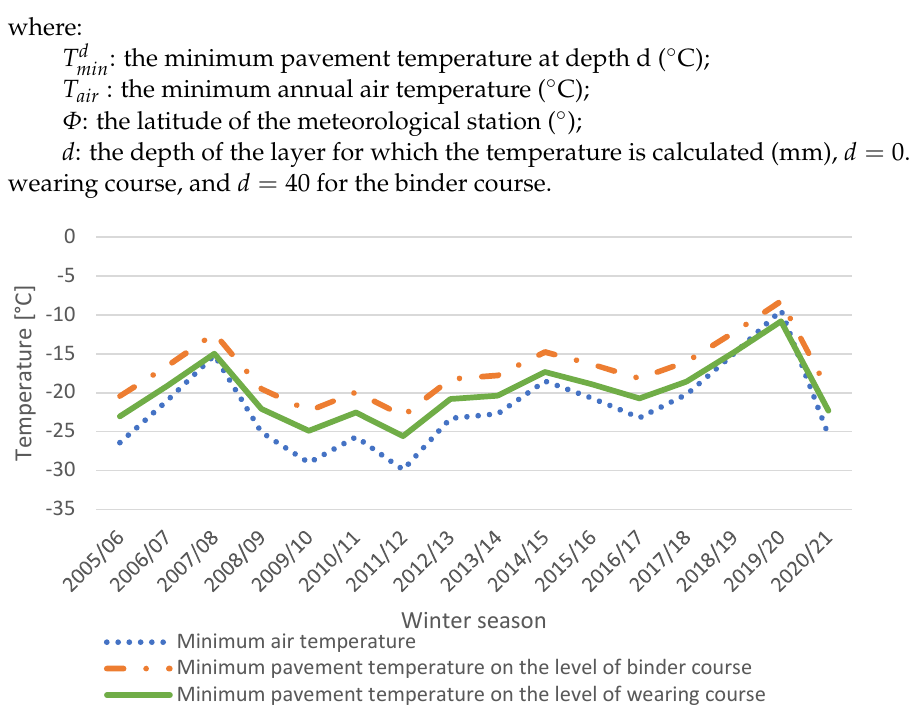
Figure 1. Minimum air and pavement temperatures during winter seasons for the considered sec- tions.